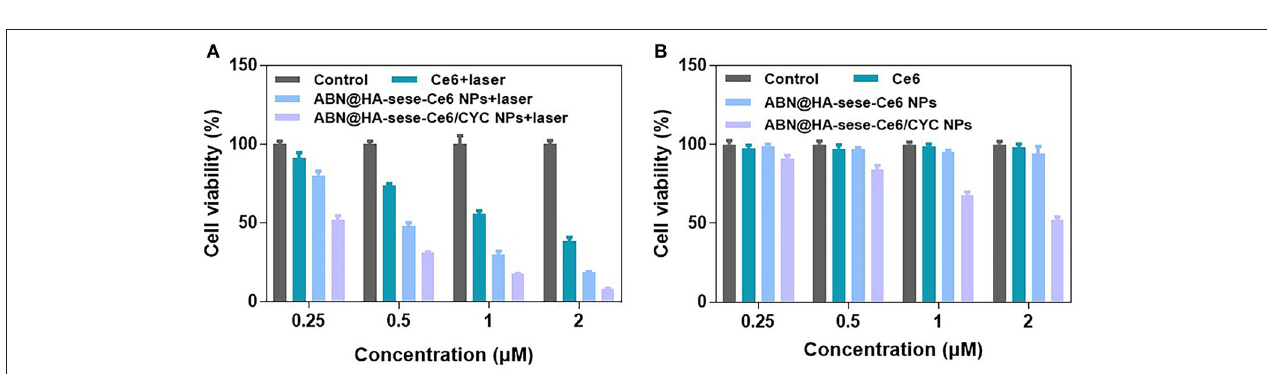
FIGURE 3 | Cytotoxicity assay in 4T1 breast cancer cells. (A) Phototoxicity of Ce6, BSA@HA-sese-Ce6, and BSA@HA-sese-Ce6@CYC (equivalent concentration 0.25–2 µ M Ce6). Fresh DMEM medium with laser as a control group; (B) Dark toxicity of above-treated groups. Fresh DMEM medium as a control